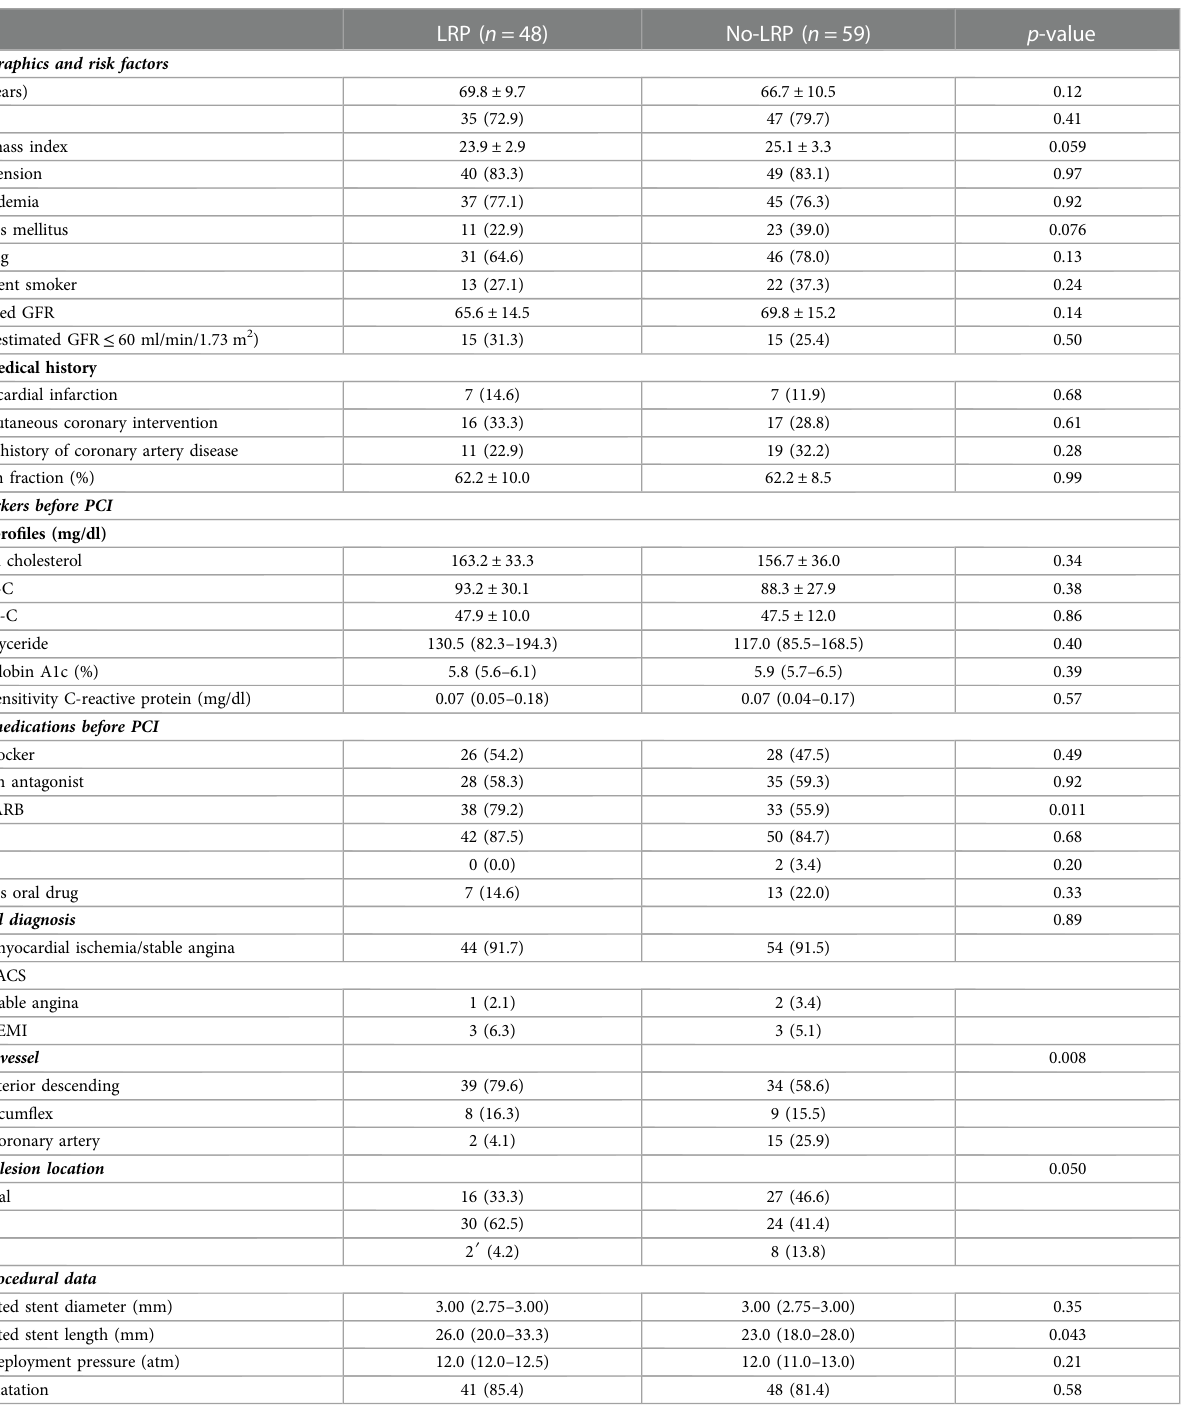
TABLE 1 Baseline patient and lesion